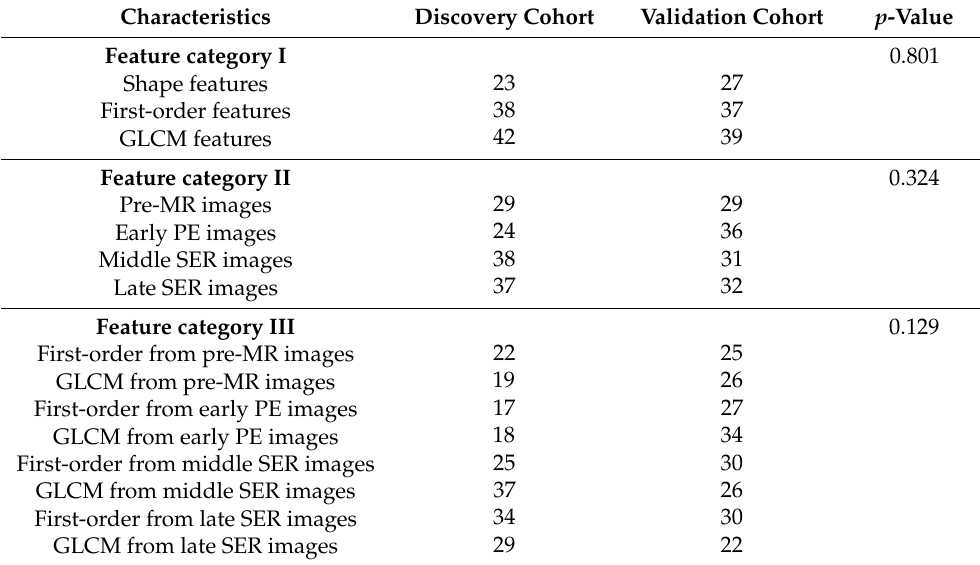
Table 3. The number of radiomic-associated hallmark pathways of each type of DCE-MRI feature. The number of significant imaging-correlated hallmark pathways was counted for each class of imaging features in both cohorts, and whether the radiomic–transcriptomic associations were significantly different in the two independent datasets is